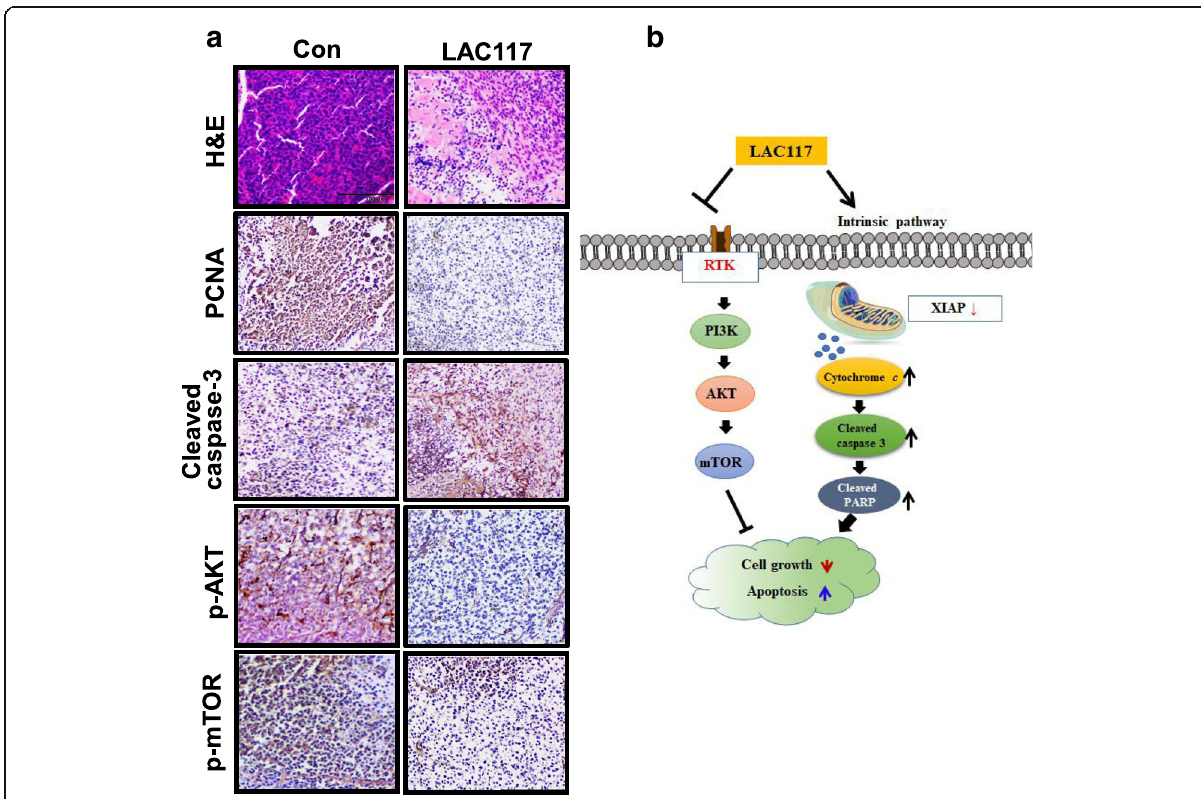
Fig. 7 Effect of LAC117 on the proliferation and apoptosis in HepG2 xenografts. a Tumors were immunostained for PCNA, cleaved caspase-3, p-AKT, and p-mTOR including H&E staining. b Scheme for how LAC117 induces apoptosis and inhibits the growth of HCC cells. The results were observed by microscopy at ×400